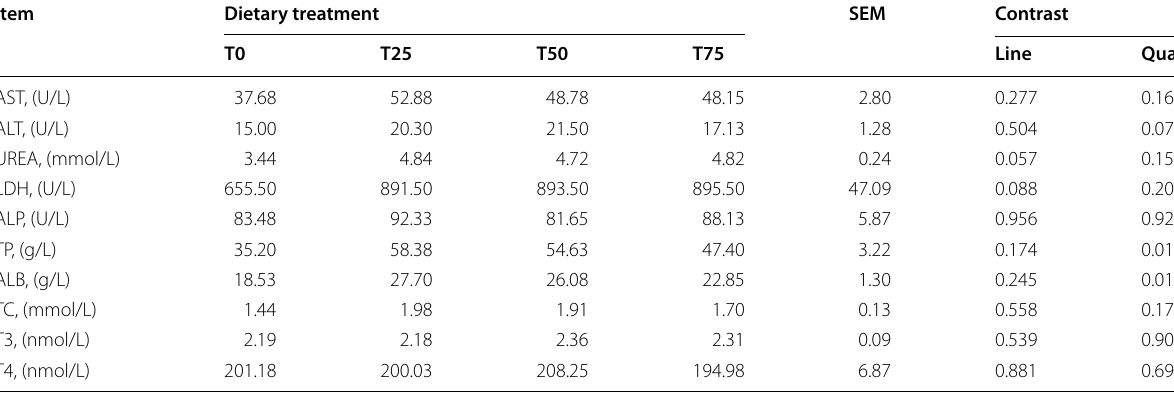
Table 2 Effects of BPS on serum biochemical indicatores of Holstein heifers